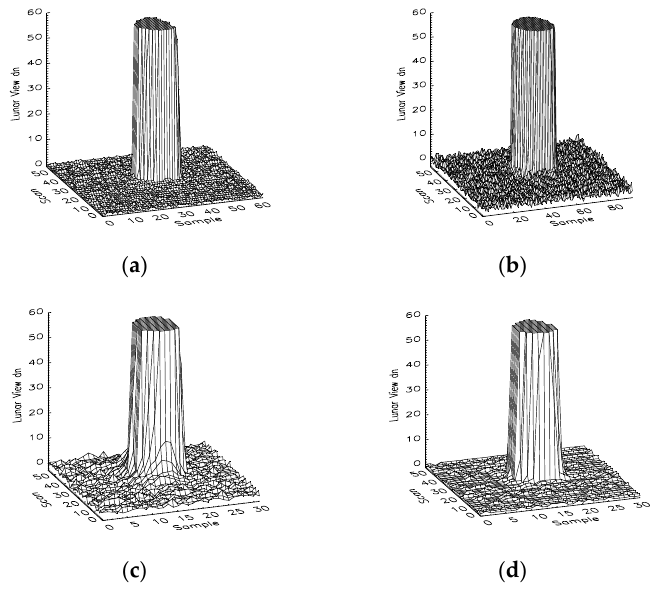
Figure 2. Lunar images observed by SNPP VIIRS reflective solar bands I1, M1, M6, and M11 on 2 April 2012: ( a ) Band I1 detector 16, ( b ) Band M1 detector 8, ( c ) Band M6 detector 8, and ( d ) Band M11 detector 8.